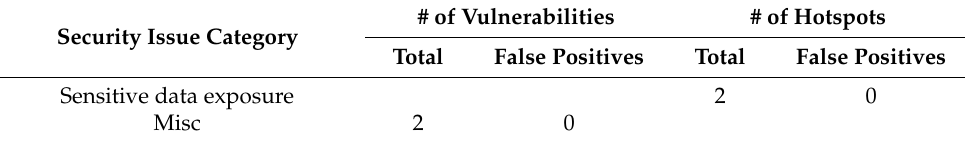
Table 13. Number of security issues of different categories in